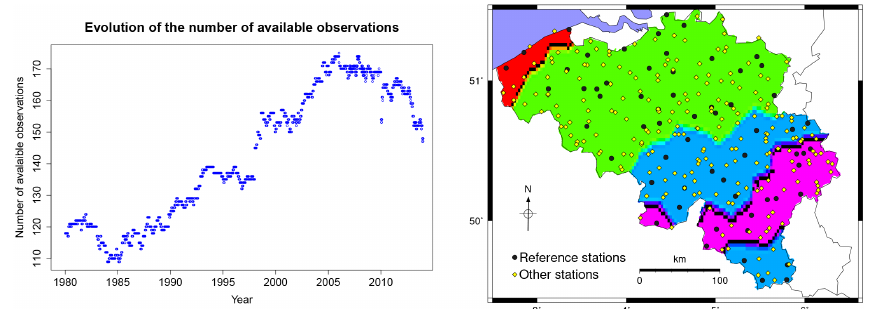
Figure 1. Evolution of the number of available observations per day for the period 1980 to 2013 (left panel) and location of the stations in operation between 1980 and 2013 with the division into 4 climate zones (right panel). Reference stations (i.e. less than 5% of missing temperature records) are indicated by a black dot while the other stations are represented by a yellow diamond.